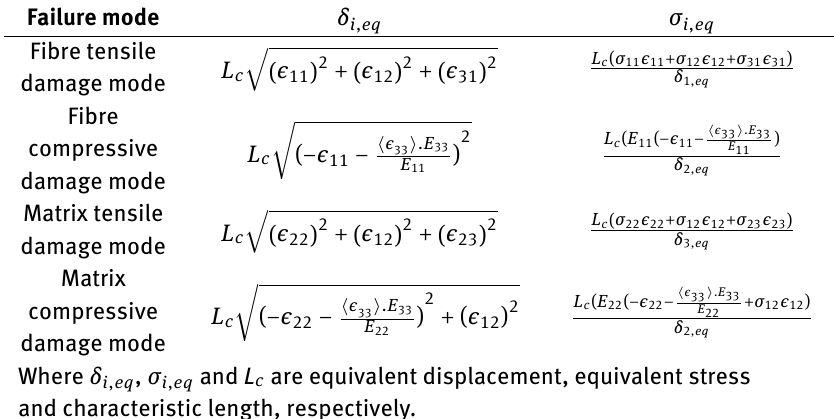
Table 4: Equivalent displacement and equivalent stress for each mode [32]